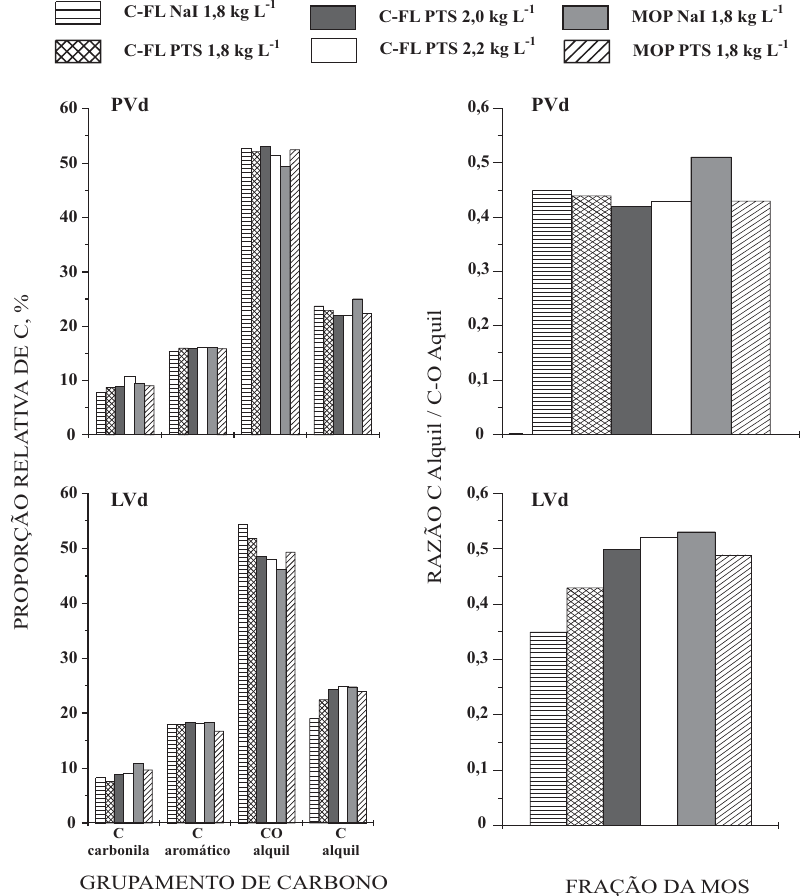
Figura 5. Distribuição relativa dos grupamentos de C quantificados por RMN 13 C da fração leve da matéria orgânica (FL) e da matéria orgânica particulada residual (MOP) e razão entre os grupamentos C Alquil e C-O Alquil de um Argissolo Vermelho (PVd) e de um Latossolo Vermelho (LVd) obtida em fracionamento densimétrico com soluções de iodeto de sódio (NaI) e politungstato de sódio (PTS). Análises realizadas em amostras compostas das repetições de laboratório e não analisadas